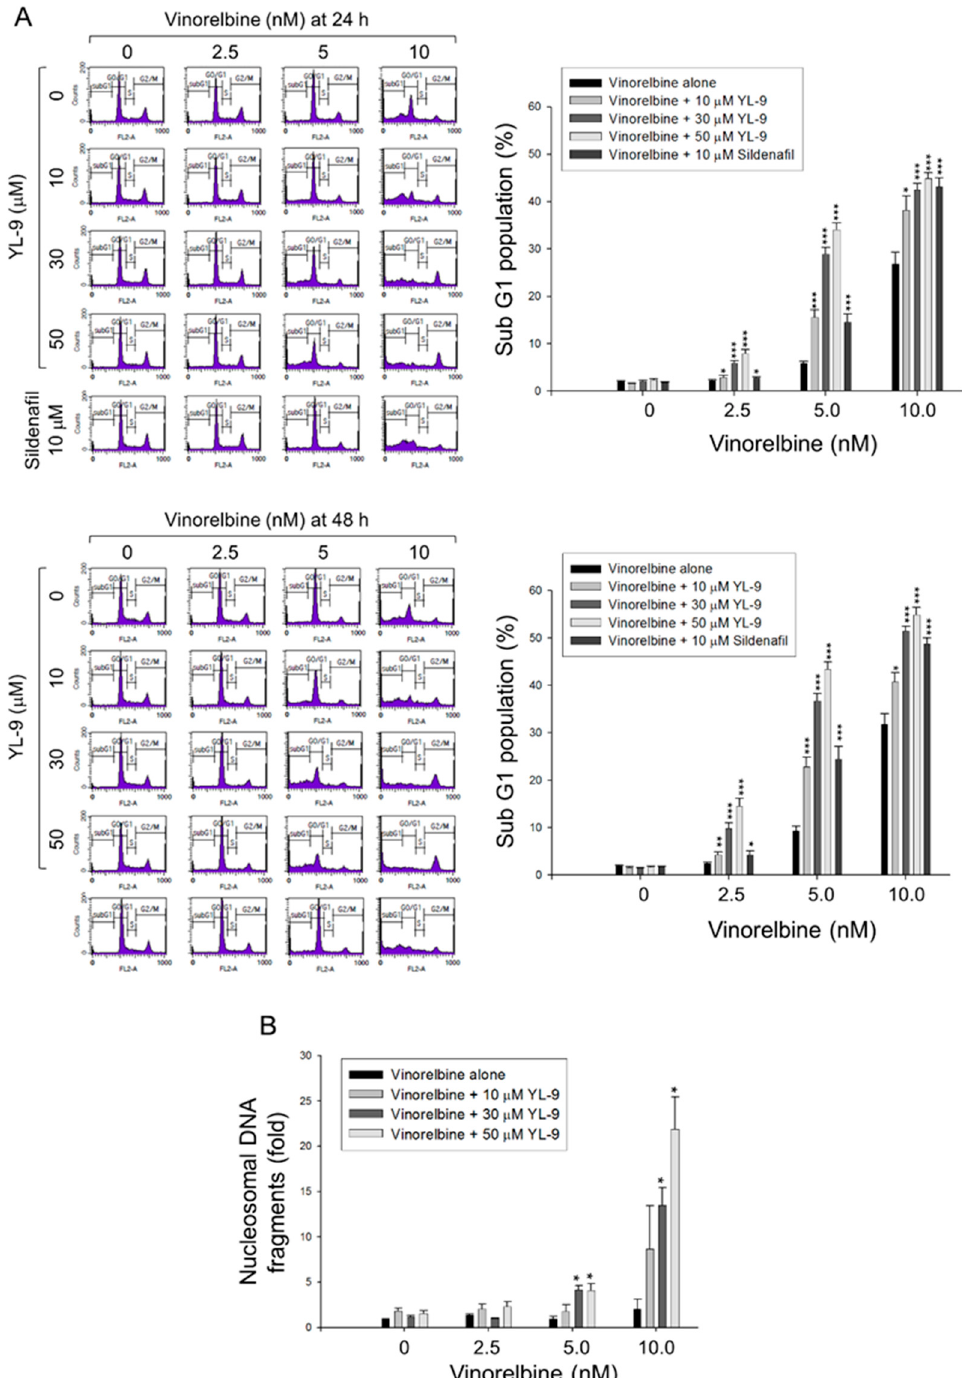
Figure 2. E ff ect of YL-9 on vinorelbine-induced apoptosis in NCI-H460 cells. ( A ) The cells were incubated with various concentrations of vinorelbine in the absence or presence of YL-9 or sildenafil for 24 or 48 h. After the treatment, the cells were harvested for the detection of cell populations at di ff erent cell cycle phases using flow cytometric analysis of propidium iodide staining. The sub-G1 populations (apoptosis) were presented as mean ± SEM of six independent experiments. ( B ) The cells were incubated with the indicated agents for 24 h. Cell apoptosis was examined by detecting nucleosomal DNA fragmentation using Cell Death Detection ELISA PLUS kit. Data are expressed as mean ± SEM of three independent experiments. * p < 0.05, ** p < 0.01 and *** p < 0.001 compared with vinorelbine alone.